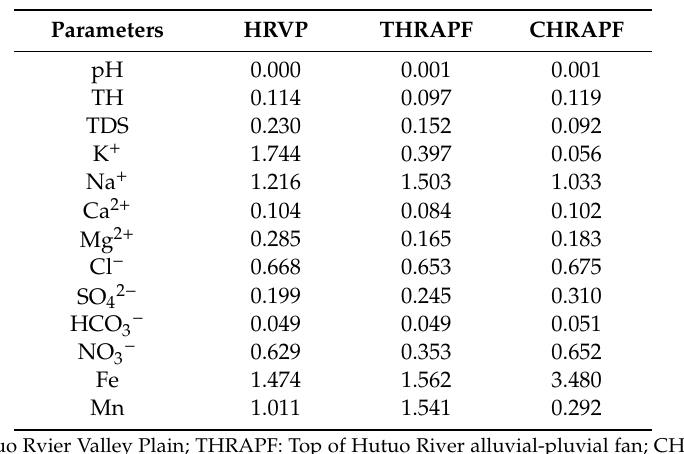
Table 3. Variance analysis of contrast coe ffi cient of groundwater hydrochemical compositions in the Hutuo River alluvial-pluvial